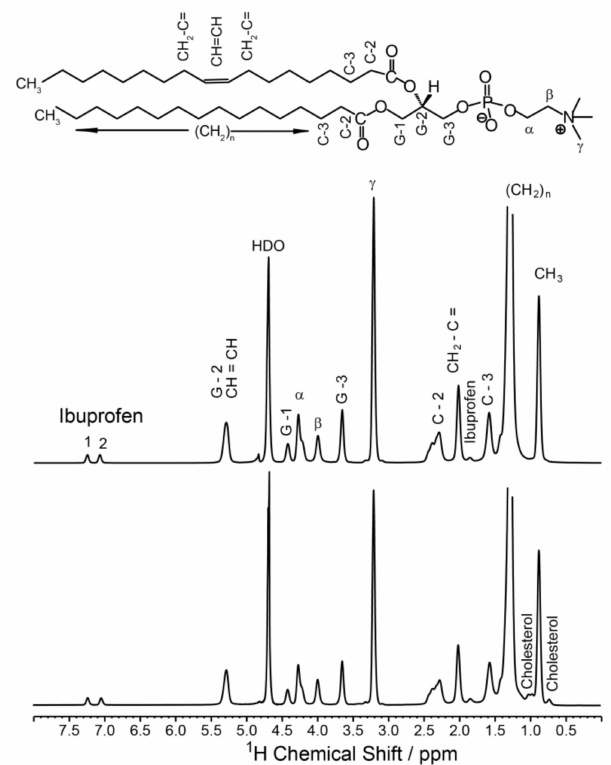
Figure 4. 1 H MAS NMR spectra of POPC membranes ( top ) and POPC / cholesterol (80 / 20, mol / mol) ( bottom ) in the presence of 10 mol% ibuprofen. Resolved signals of ibuprofen and cholesterol are marked; the assignment of the POPC peaks (nomenclature see chemical structure of POPC above the spectra) was taken from [23]. HDO denotes the signal of residual water. The NMR spectra were measured at a MAS frequency of 6,000 Hz and a temperature of 30 ◦ C.